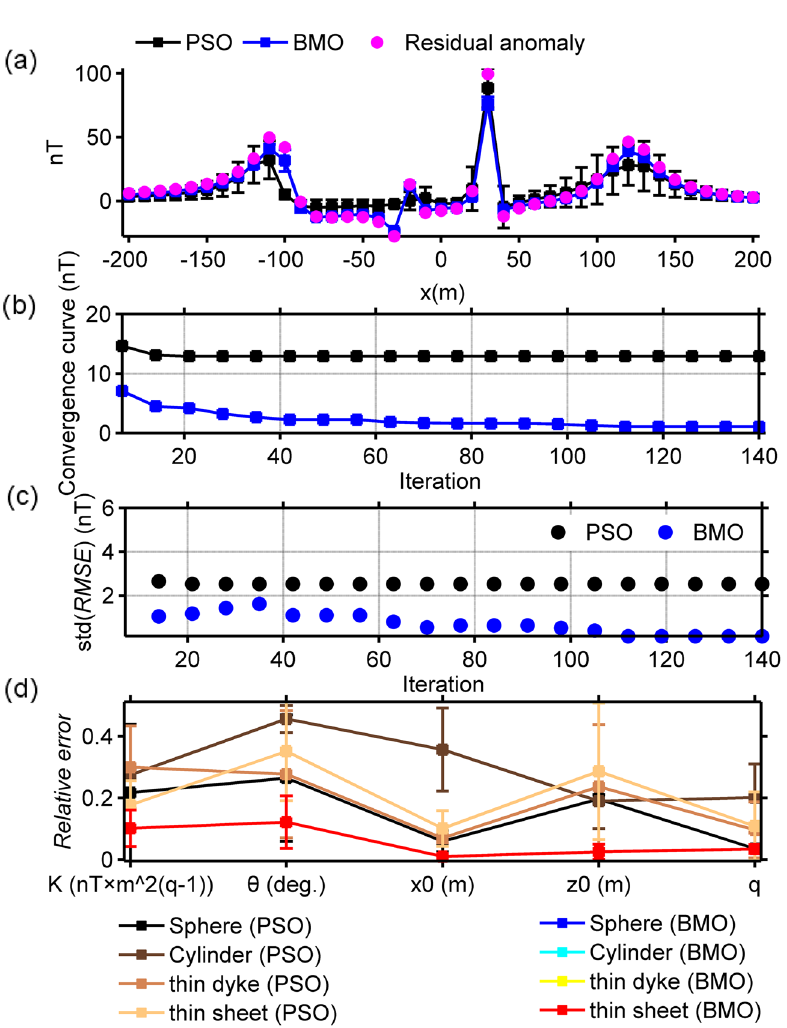
Figure 6. Inversion results of case 1. ( a ) fittings between the simulated residual magnetic anomaly and the responses obtained via BMO and sPSO, ( b ) the variation behavior of the mean RMSE values against iterations after 30 runs, ( c ) the variation behavior of the std of RMSE values against iterations after 30 runs, ( d ) calculated relative errors of model parameter solutions using BMO and sPSO for four causative sources. Error bars are given in ( a ) and ( d